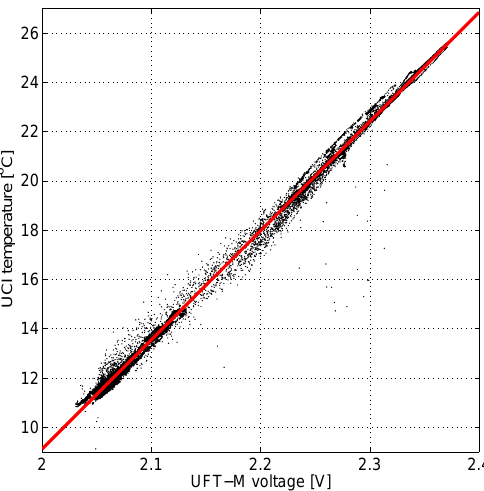
Fig. 4. Example calibration of the UFT-M1 (one sensor) against a 1Ss − 1 record from the University of California temperature sensor in Rosemount housing. Each dot corresponds to a 1s average from the